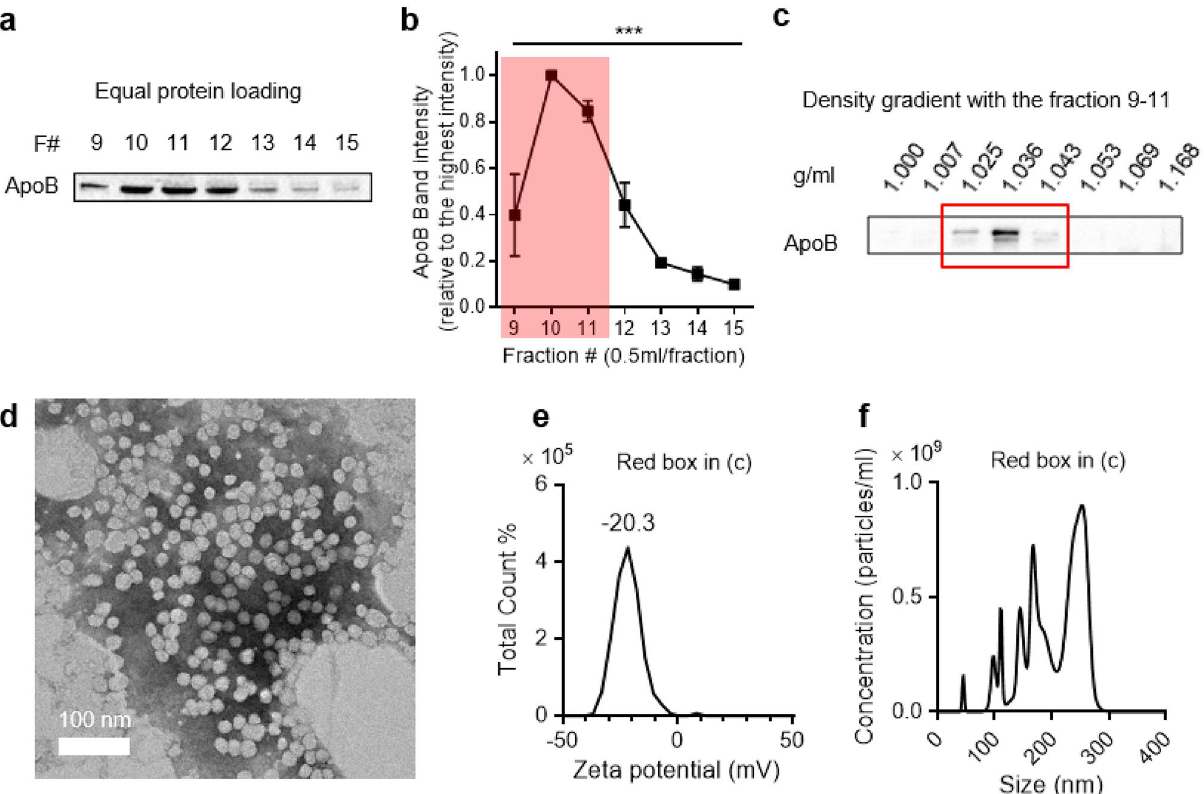
Figure 2. Enrichment of BM derived ApoB positive particles in eluate fractions 9–11 of CL-2B columns. ( a ) Western blot (equal protein loading) analysis of ApoB on eluate fractions 9–15 of BM plasma. ( b ) Relative ApoB intensities of ( a ). ( c ) Western blot analysis of ApoB in eluate fractions 9–11 of AML BM plasma after density gradient ultracentrifugation. The particles with the density in the range of 1.025–1.043 g/L (red box)